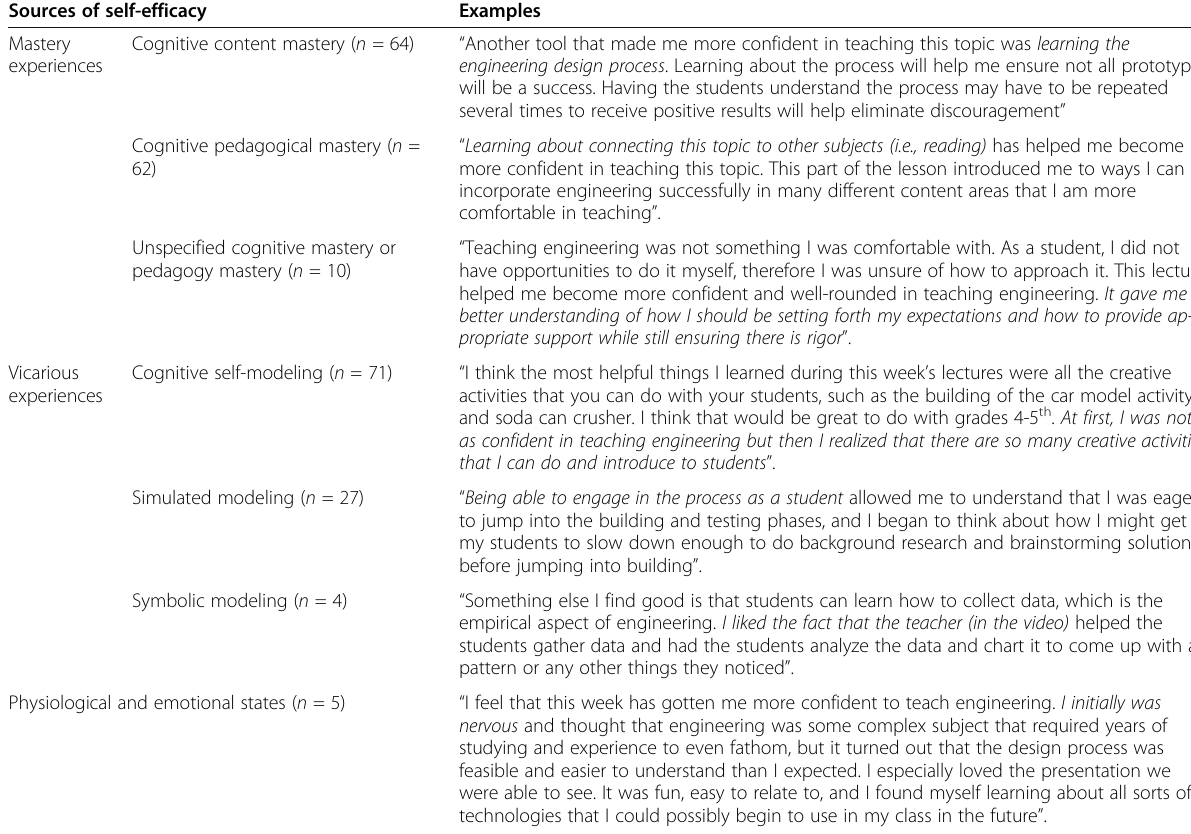
Table 3 The sources of engineering teaching self-efficacy indicated by the participant PSTs Sources of